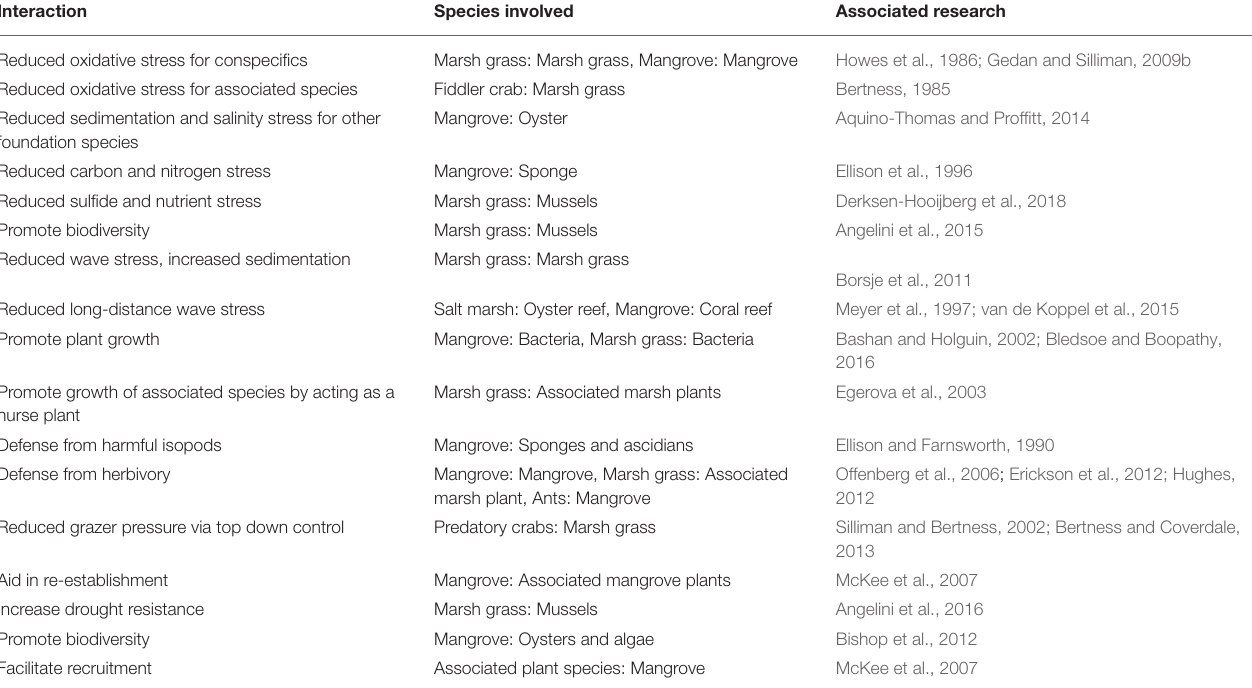
TABLE 1 | Examples of positive species interactions in salt marshes and mangroves that may be useful for restoration managers.